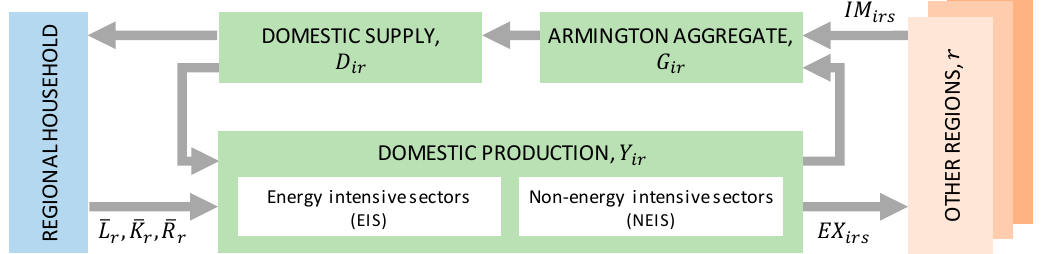
Figure 2. Economic structure of each region in the CGE model.